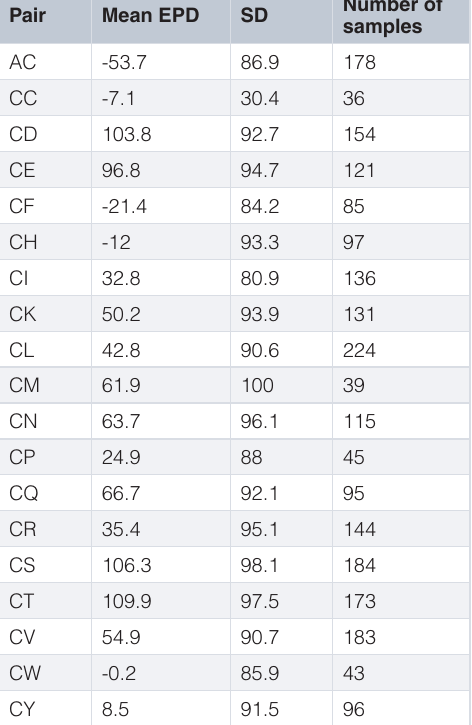
Table 2. Electrostatic potential differences (EPD) for consecutive residue pairs for C β atoms for residue pairs that has one cysteine. These pairs have a random values for the mean and a high standard deviation (SD), with the exception of the pair ‘CC’ (not the disulfide bond) which has a low mean value and SD. Consequently, these values can not discriminate between pairs of amino acids.